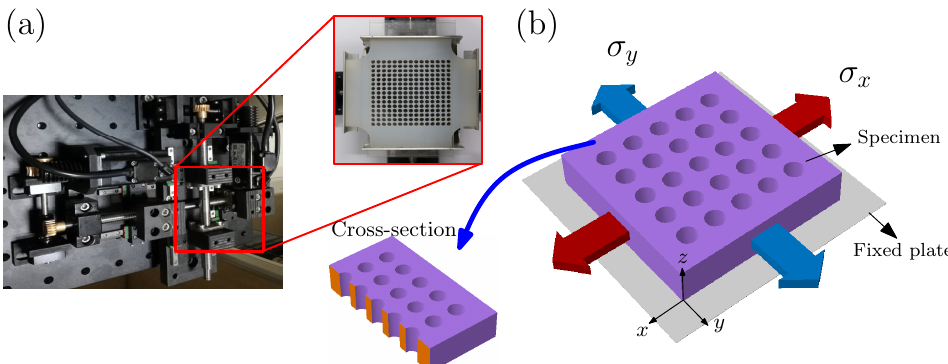
Figure 1. ( a ) A self-designed biaxial loading apparatus for porous solids. ( b ) Schematic of porous solids under biaxial loading. The upper and lower surfaces of the samples were closely fixed by two thin sheets (made of PMMA). Here, only the thin sheet of the lower surface is drawn. A biaxiality ratio is introduced for the experiments, which can be defined as: ε y γ = (1) ε x where ε x = δ x / L x and ε y = δ y / L y . L x and L y are the original length of the sample in